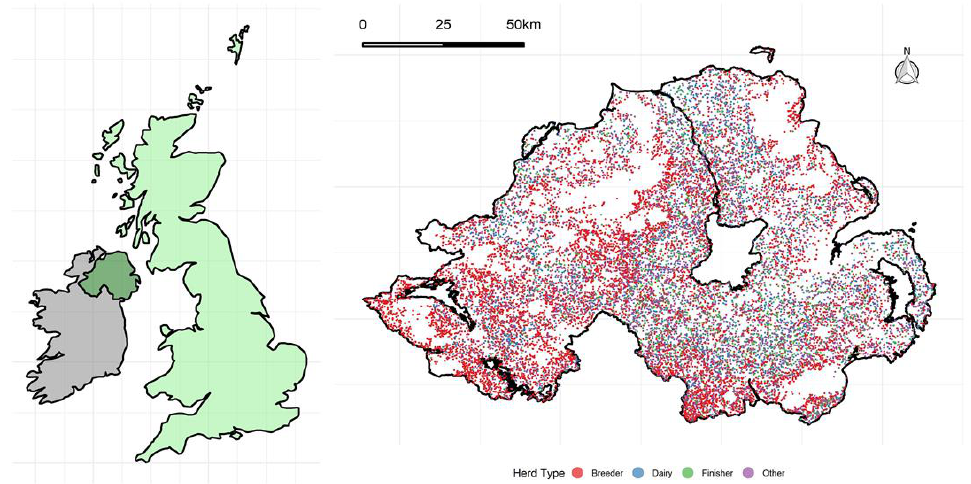
Figure 1. Distribution of cattle herds in Northern Ireland, with point locations representing the reg- istered farmstead latitude and longitude co-ordinates.